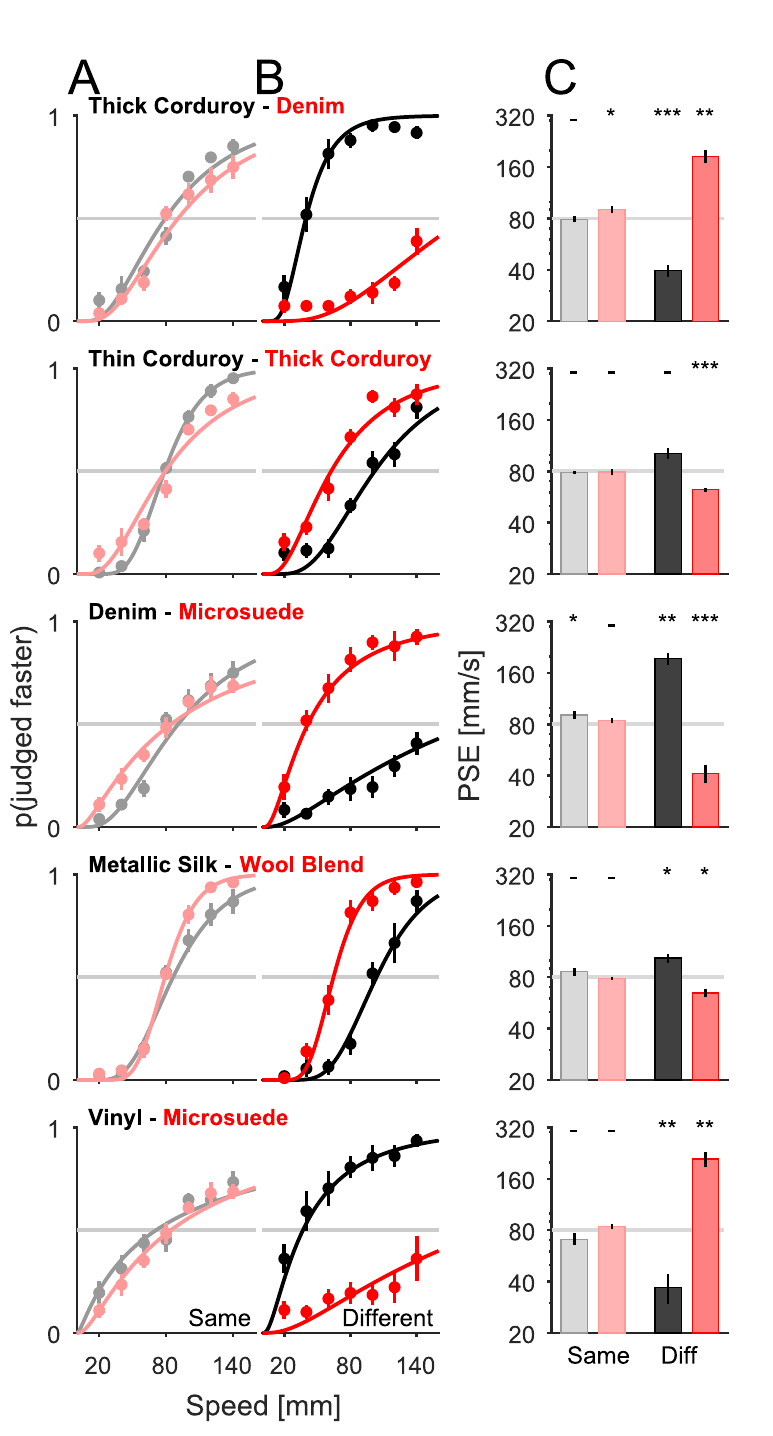
Fig 3. Speed discrimination across textures. (A, B) Discrimination performance—as gauged by the proportion of trials on which the comparison was judged to be faster than the reference versus speed—averaged across subjects for each texture pair. In (A), the reference and comparison were the same texture (reproduced from Fig 2 , but organized by pairs). In (B), the reference and comparison were different textures. The color (black or red) depicts the texture used as reference. (C) PSE for the same (left, light) and different (right, dark) texture pairs. Error bars denote the SEM ( n = 8 for each same pair, n = 9 subjects for each different pair). Stars reflect the outcome of a one-sample t test versus 80 mm/s ( − denotes not significant, � p < 0.05, �� p < 0.01, ��� p < 0.001). The effect of texture on PSE was consistent with the results from the magnitude estimation experiment (Fig 1C, intercepts). Data underlying this figure can be found in S1 Data. PSE, point of subjective